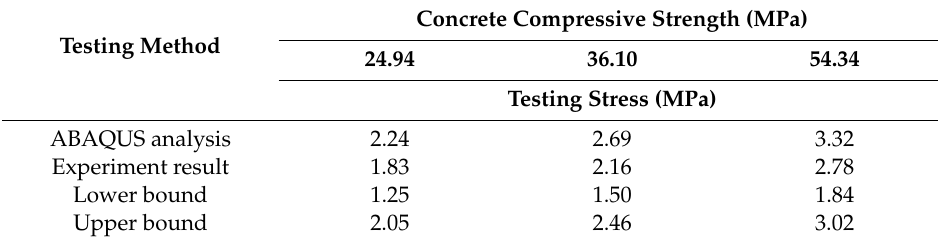
Table 8. Stress comparison with di ff erent concrete compressive strength.